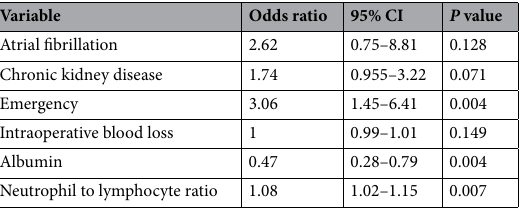
Table 4. Risk factors for acute kidney injury occurrence on multivariate analyses. CI: confidence interval.